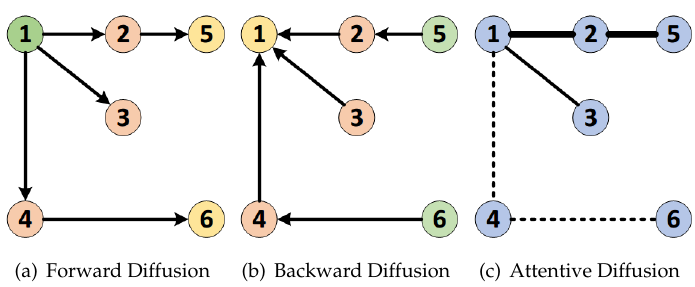
Figure 2. The illustrations of three kinds of diffusion convolution. In ( a , b ), the direction of the node chain denotes the diffusion direction of current node 1, and the nodes with the same color share the same weight in the diffusion process (e.g., nodes 5,6 share the same weight with time-step k = 2). In ( c ), the edges indicate the relationship between two nodes (e.g., the dotted edge <1,4> indicates a weak connection based on Graph Attention Mechanism